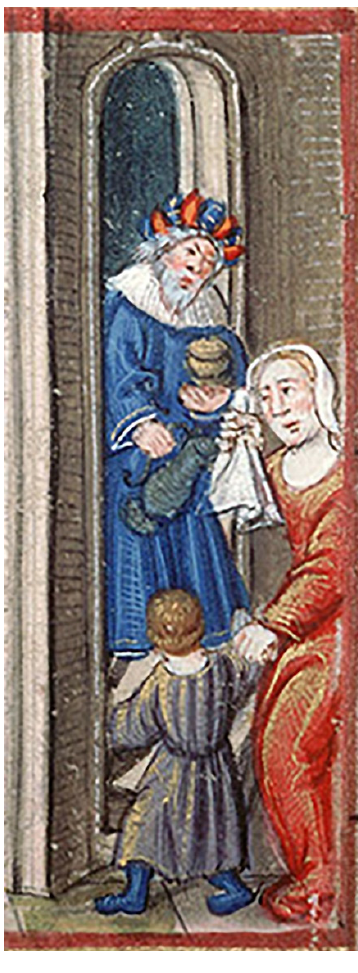
Figure 6. Book of Hours , late 15th century or early 16th century. Amiens, Bibliothèque municipale, ms. 107, f. 7v.